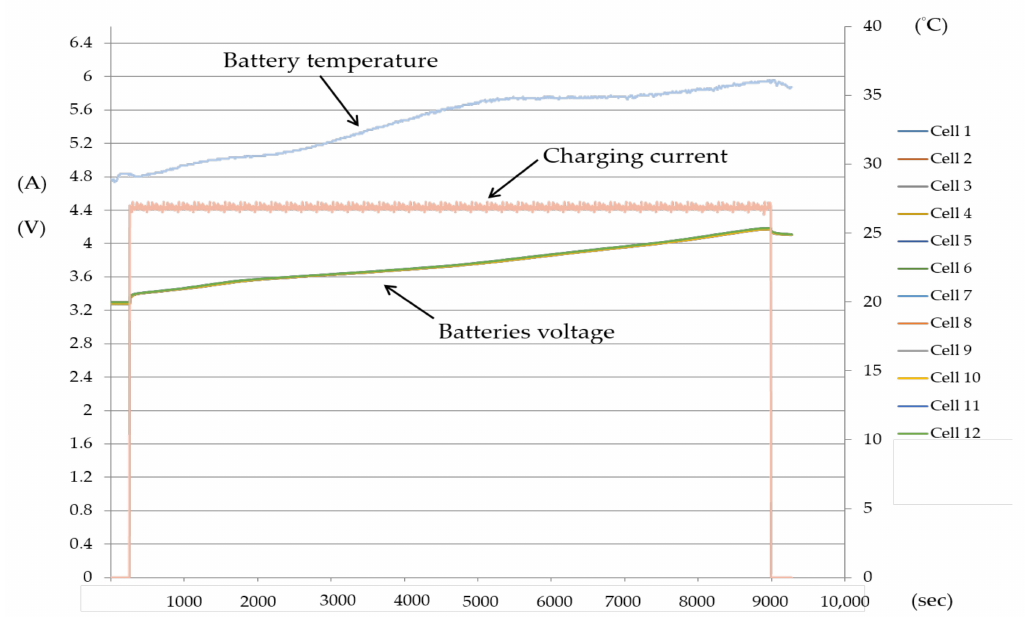
Figure 16. Overcharge protection of the lithium-ion battery module.